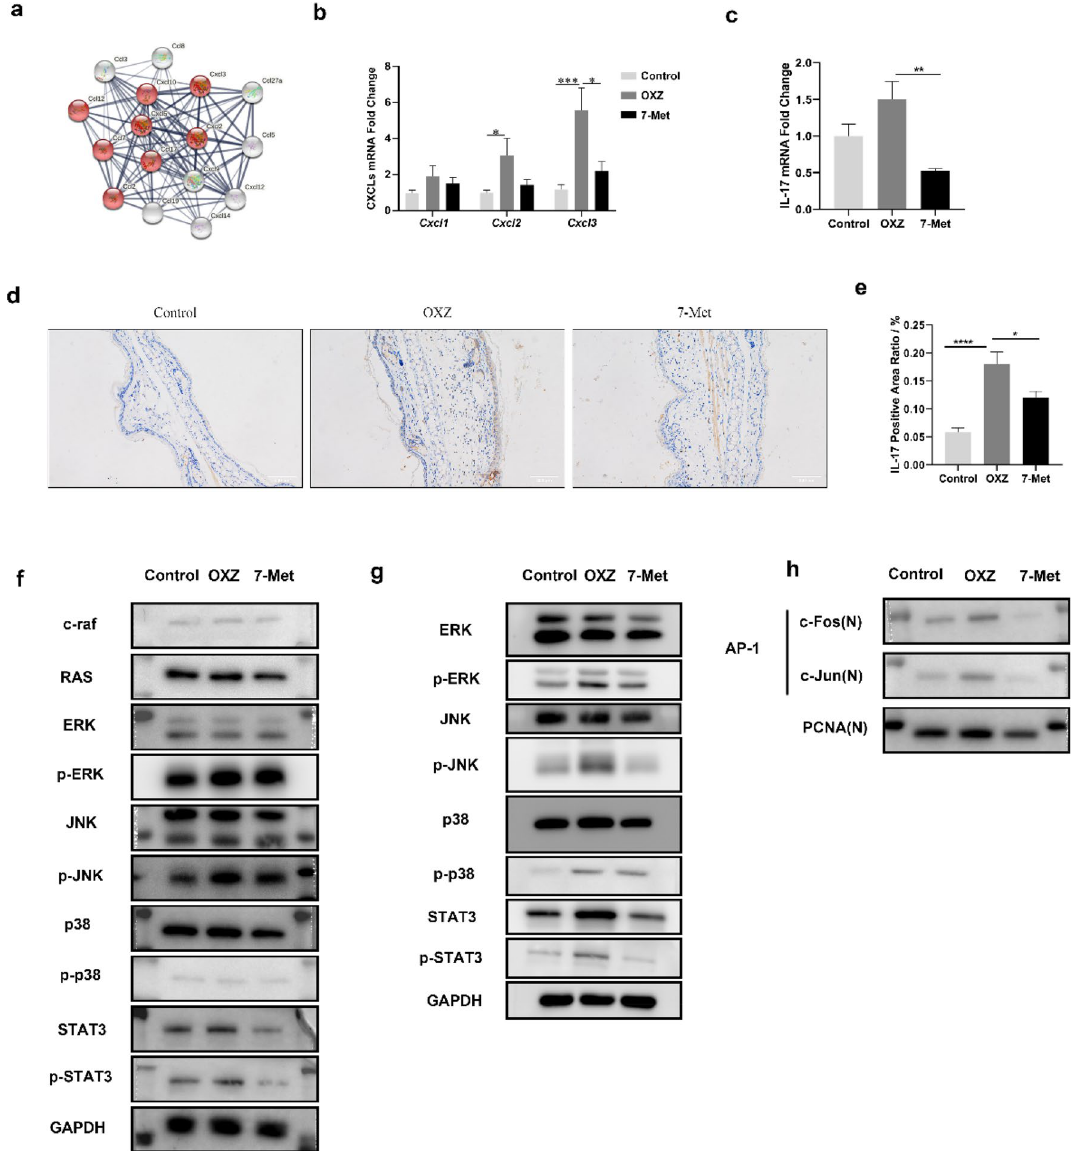
Figure 6. 7-Methoxyisoflavone downregulated Th17 cells subset. ( a ) Protein–protein interaction (PPI) network of OXZ-induced differentially expressed (|Foldchange|> 2, q < 0.05) chemokines mRNAs, the nodes in red indicate genes involved in the IL-17 signaling pathway (KEGG: mmu04657, FDR < 0.0001). ( b ) Relative Cxcl1, Cxcl2 and Cxcl3 mRNA levels were determined by quantitative RT-qPCR. ( c ) Relative IL-17A mRNA levels were determined by quantitative RT-PCR (p 7-met = 0.0096, two-tailed). ( d ) Immunohistochemistry staining of IL-17A+ Th17 cells. ( e ) IL-17A positive area ratio was calculated by ImageJ software (n = 6). (p model < 0.0001, two- tailed, p 7-met = 0.0243). ( f ) The phosphorylation of MAPKs and STAT3 in the ears total protein was analyzed by Western blotting. ( g ) The phosphorylation of MAPKs and STAT3 in the dorsal skin total protein was analyzed by Western blotting. ( h ) The nuclear translocation of AP-1 was analyzed by Western blotting. The expression levels of Ras, c-Raf, p-ERK, ERK, p-JNK, JNK, p-p38 and p38 in the total protein and the nuclear translocation of c-Jun and c-Fos of the right ears were detected by Western blotting. *p < 0.05 and ****p < 0.0001. p-STAT3 phospho-STAT3(Tyr705); STAT3 , STAT3(124H6). 7-Met 7-Methoxyisoflavone, p65 (N) nucleus p65, p-ERK phospho-p44/42MAPK(ERK1/2), ERK p44/42MAP Kinase, p-p38 phospho-p38 MAPK (Thr180/Tyr182), p38 , p38 MAPK, c-Fos (N) nucleus c-Fos, c-Jun (N) nucleus. In order to avoid the interference of non-specific